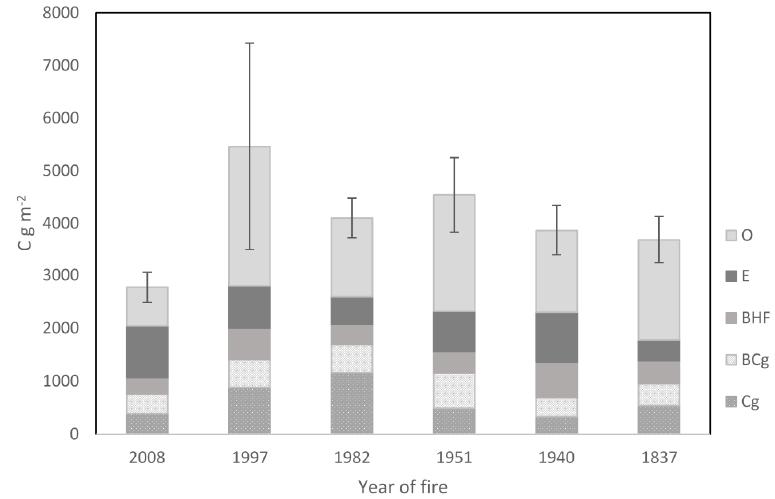
Figure 4. Average soil C content (C·g·m − 2 ) in different horizons (O-/E-/BHF-/BCg-/Cg-horizon) in a fire chronosequence.